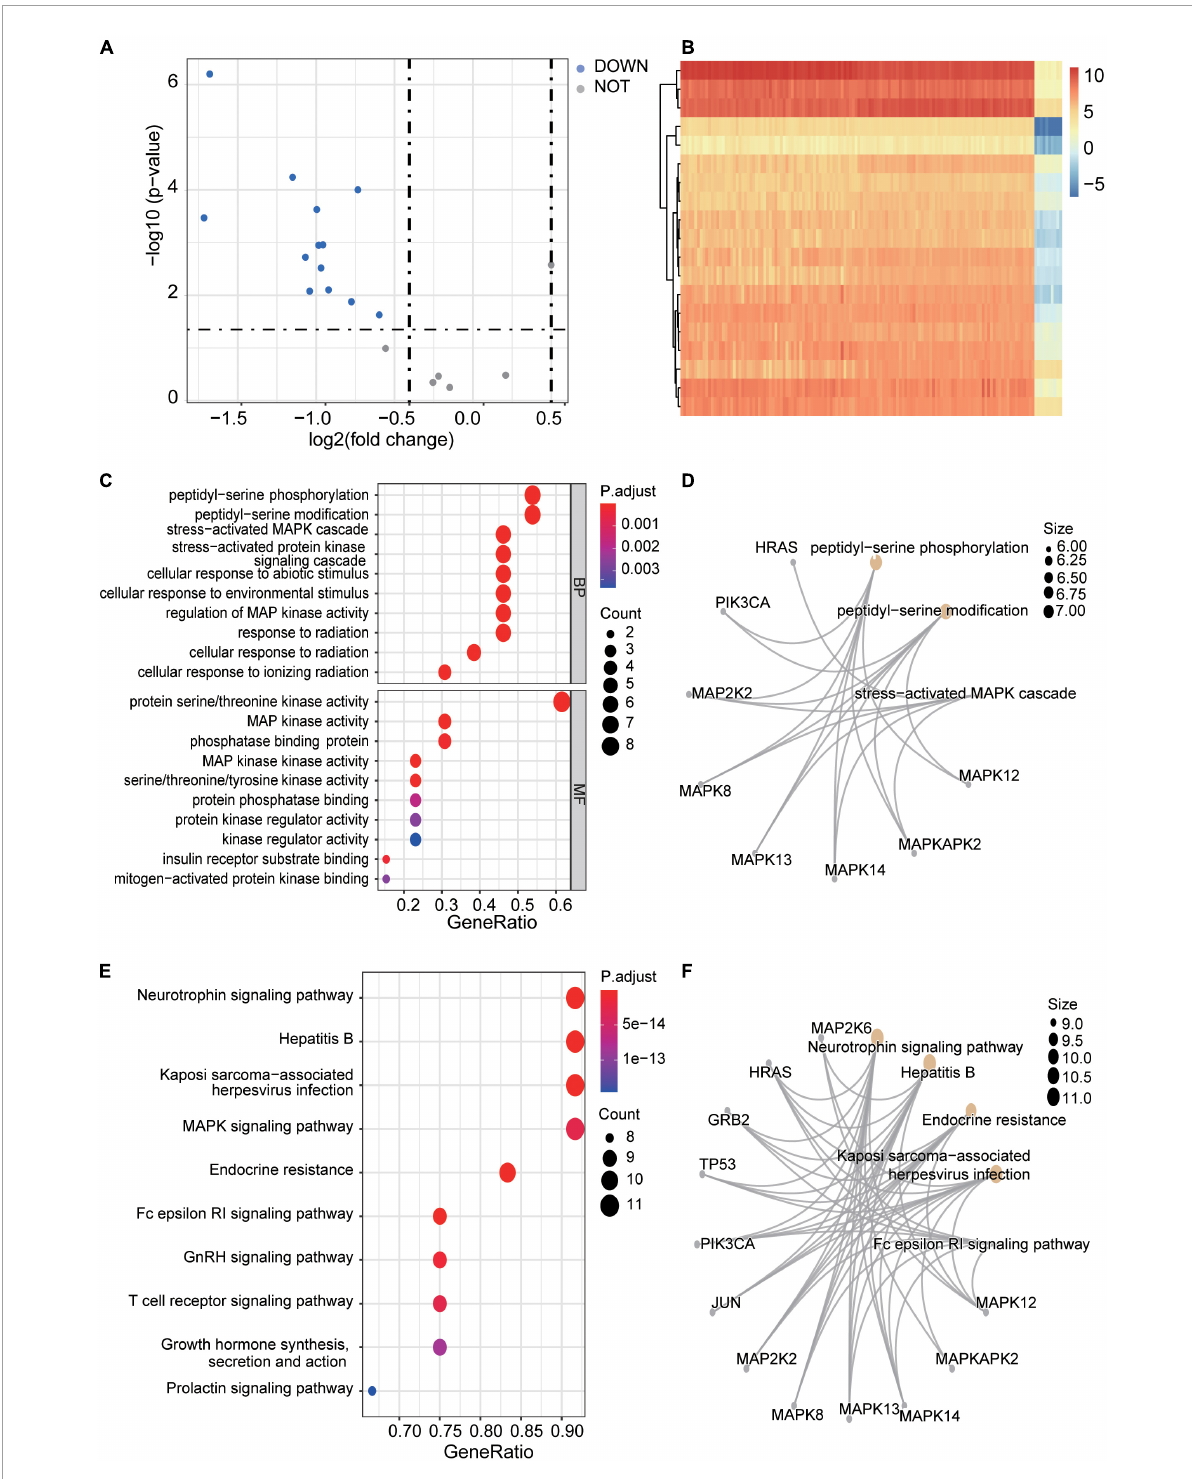
FIGURE5 DEGs identification in subtypes and enrichment analyses. (A) A Volcano plot of the DEGs of exprSet after clustering. The blue nodes represent down-regulated DEGs. The dark nodes indicate Stable-genes. There is no up-regulated gene. (B) A heatmap of all DEGs of exprSet. Each column represents one sample, and each row represents one gene. The color changes from blue to red represents the changes from downregulation to upregulation for the expression. (C,D) The visualization of the results of GO enrichment analyses. (E,F) The visualization of the results of the KEGG pathway enrichment